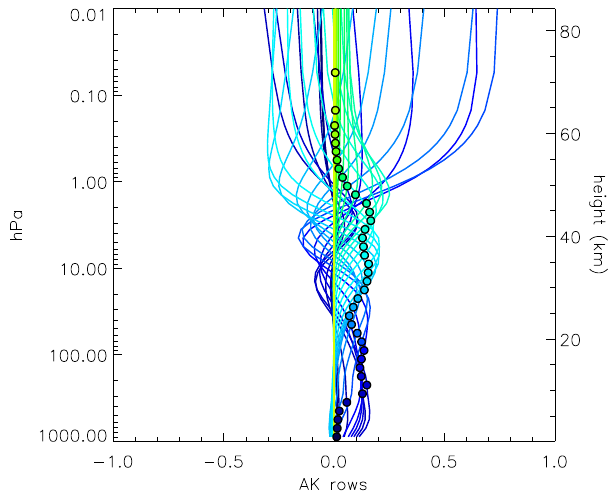
Fig. 11a. Averaging kernels for the 40-layer GOME-2 retrieval over Europe that was also used in Fig. 1. The circles give the nominal altitude for the retrieval. The averaging kernels corresponding to the albedo and the additive offset have not been plotted.